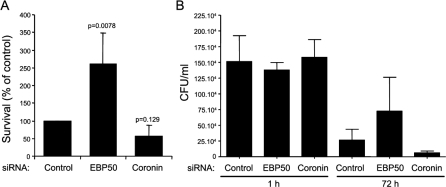
Mycobacterial Killing in IFN-γ- and LPS-Induced Macrophages Is Mediated by EBP50Murine macrophages were transfected with control (scramble), EBP50, or coronin 1 siRNAs for 48 h, activated with IFN-γ and LPS overnight prior to infection with BCG in the presence of IFN-γ and LPS, and survival determined by CFU counting. The results in (A) are percents relative to control siRNA normalized to 1 h time point or shown as CFU (B). Bars, mean ± s.e.m. (three independent experiments).